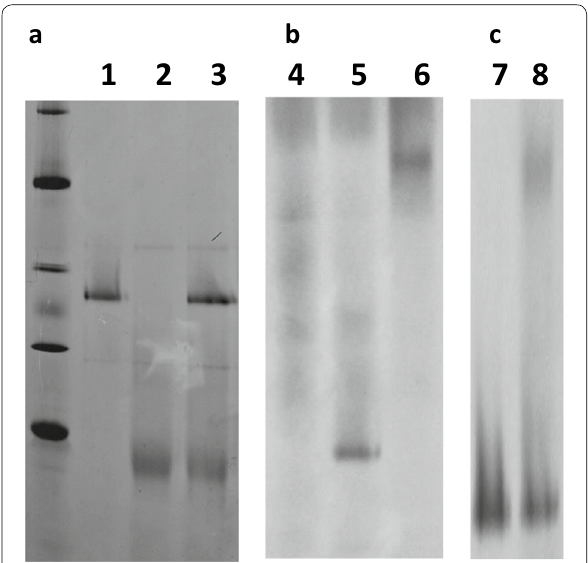
Fig. 2 Analysis of enzyme-complex formation by NativePAGE ™ . Electrophoretic mobility of components and assembled complexes on nondenaturing gels. Recombinant S1 (rS1), native S1 (nS1), rXyn11A and rXynXL (Xyn11A lacking the family 36 carbohydrate-binding module) were allowed to interact overnight at room temperature. Lane 1, rS1; lane 2, rXyn11A; lane 3; interaction of rS1 and rXyn11A; lane 4, nS1; lane 5, rXyn11A; lane 6, interaction of nS1 and rXyn11A; lane 7, rXynXL; lane 8, interaction of nS1 and rXynXL. Lanes 1–3 are from the same nondenaturing gel. Lanes